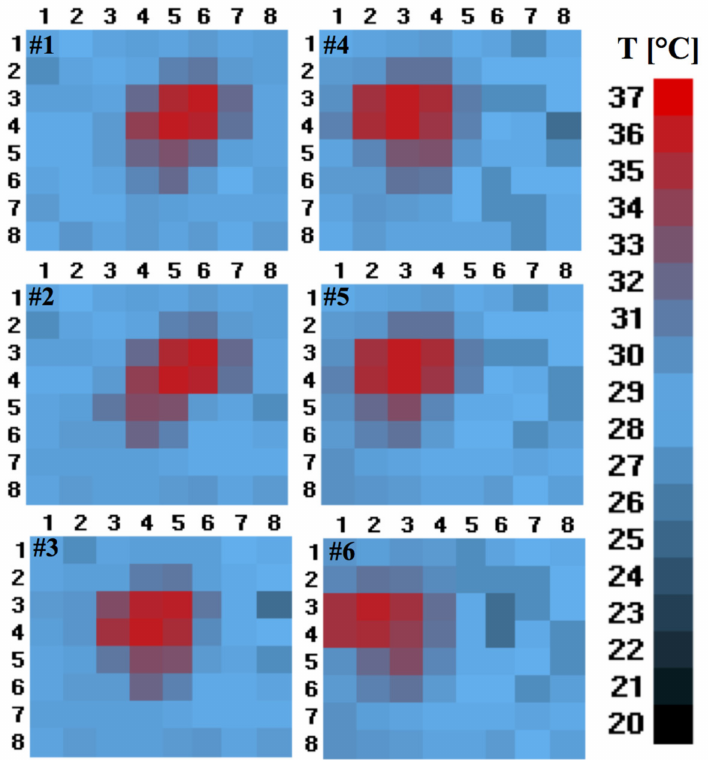
Figure 8. Six frames captured during the passage of a person recorded during the data collection and data processing of the software. The bar represents the temperature scale in ◦